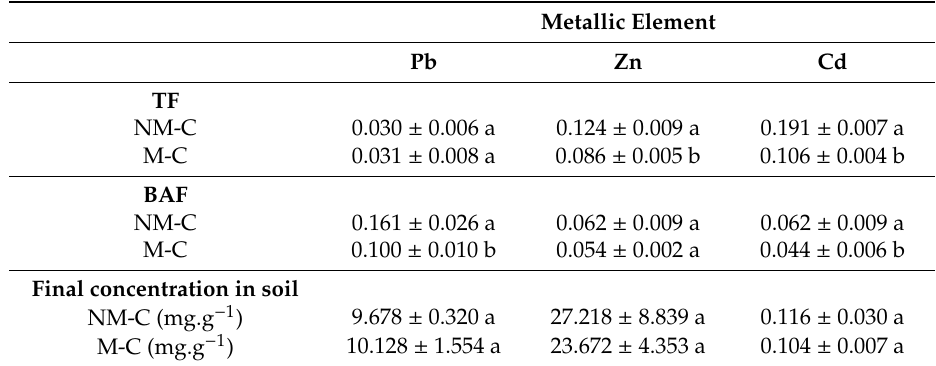
Table 4. Translocation factor (TF), bioaccumulation factor (BAF), and final concentrations of heavy metals (Pb, Zn, and Cd) in contaminated soil 12 months after commencing the